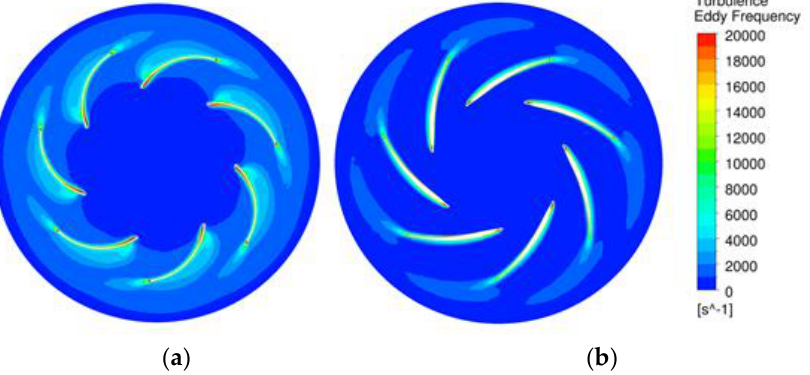
Figure 16. Turbulence eddy frequency (at 1100 rpm): ( a ) Original model; ( b ) Optimized